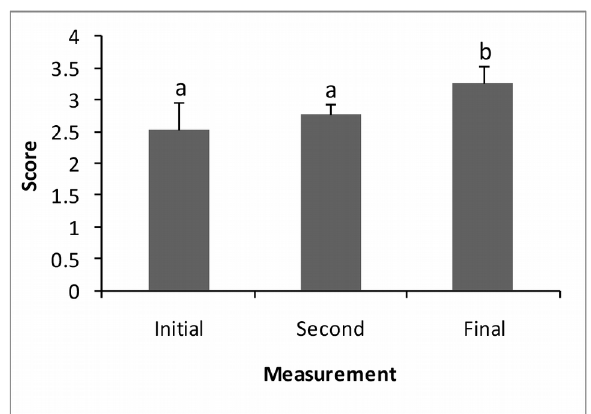
Figure 2. Improvement of students’ SPS score from initial to final